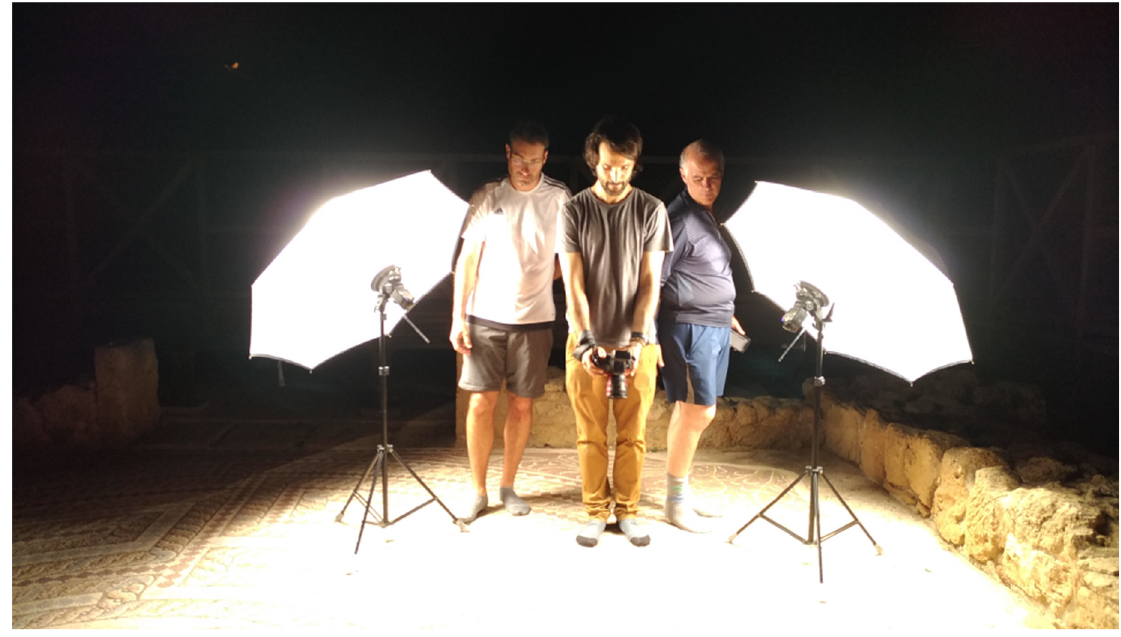
Fig. 12 Team recording the exposed mosaics with diffused lighting (Source: the